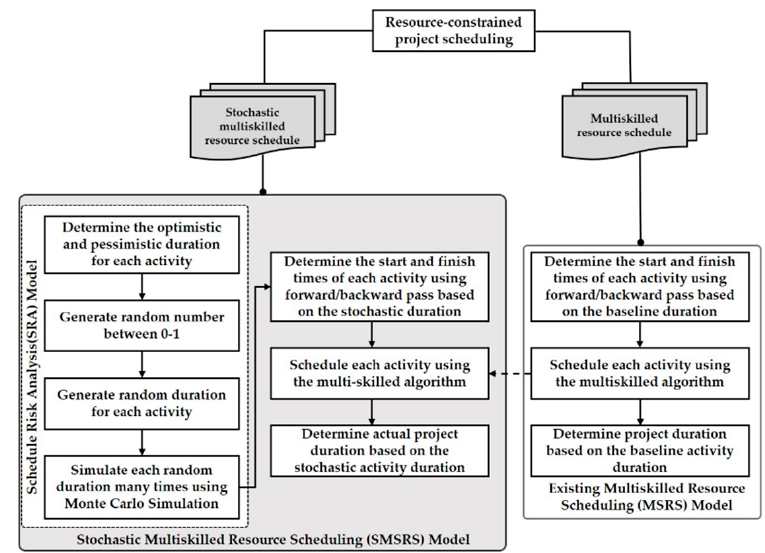
Figure 1. Overview of research methodology. Table 2. Project information for project A.